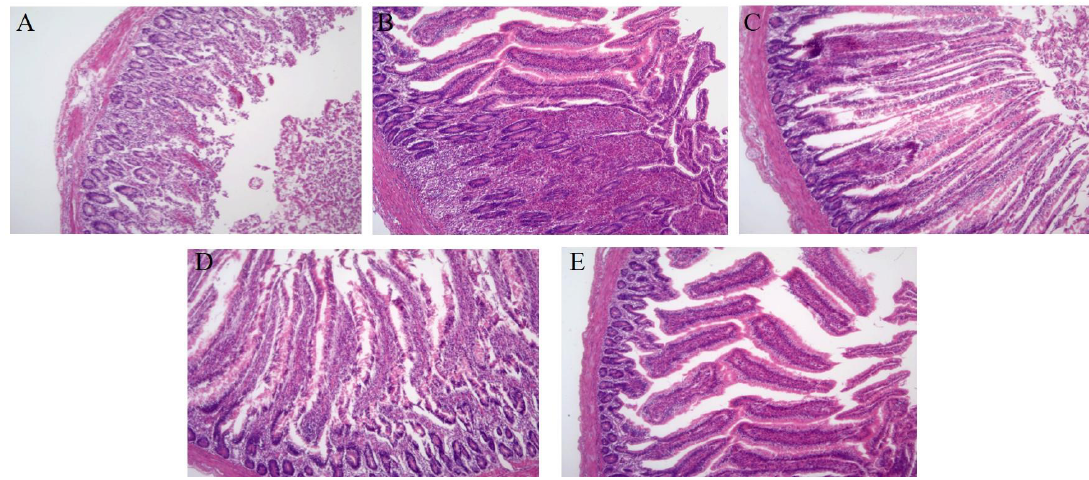
Figure 7. Intestinal H&E staining (100×). ( A ) Control group, ( B ) pPICZ group, ( C ) Phage group, ( D ) LySP2 group, ( E ) Normal group. ( D ) LySP2 group, ( E ) Normal